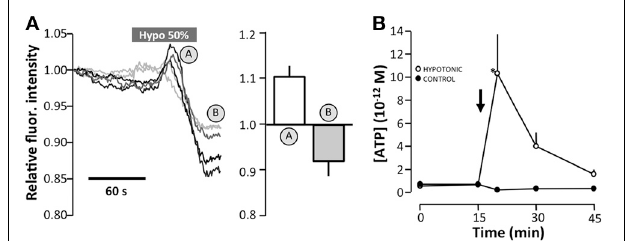
FIGURE 8 | The effect of hyposmotic stress on vesicular fusion of quinacrine-loaded vesicles by TIRF microscopy of MDCK cells. (A) Original traces of the total fluorescence intensity of 5 cells as determined by TIRF microscopy. The mean ± s.e.m. values are shown on the right as n = 17. (B) Effect of apically-induced hypotonic stress (50%) on the level of extracellular ATP. Data are presented as the mean ± s.e.m. ( n = 10). The asterisk indicates statistical